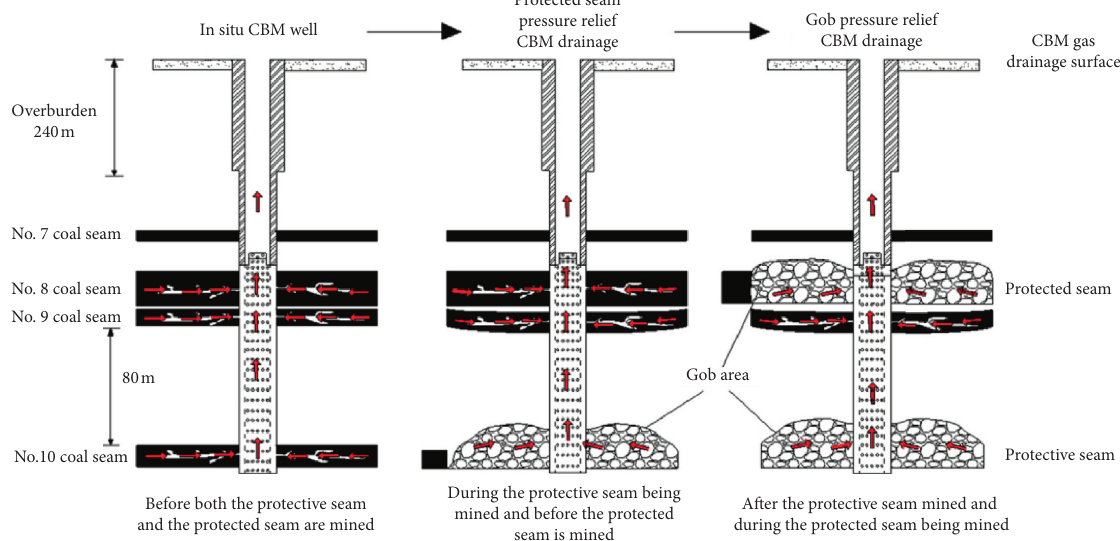
Figure 2: Different stages of pressure relief CMM extraction of the multipurpose well modified from the work of Wang et al.